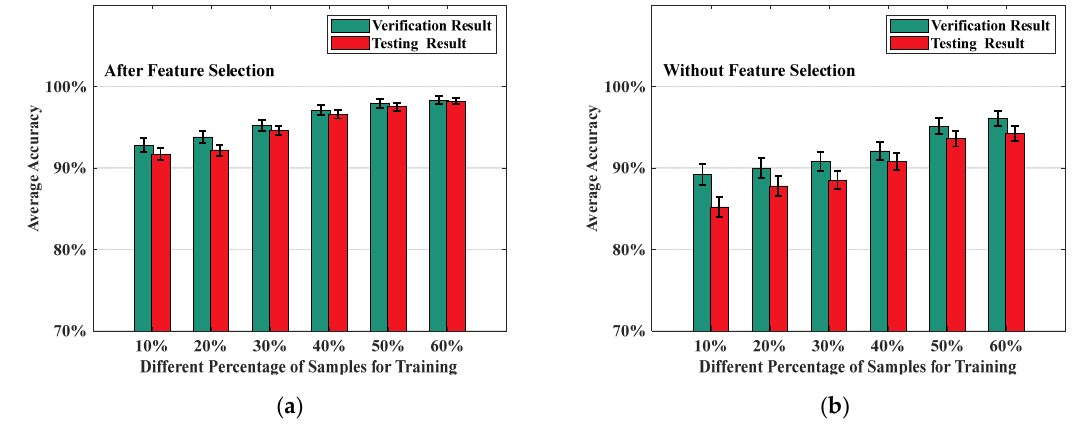
Figure 14. Accuracy comparison with different training percentages. ( a ) Accuracy with feature selection; ( b ) Accuracy without feature selection.